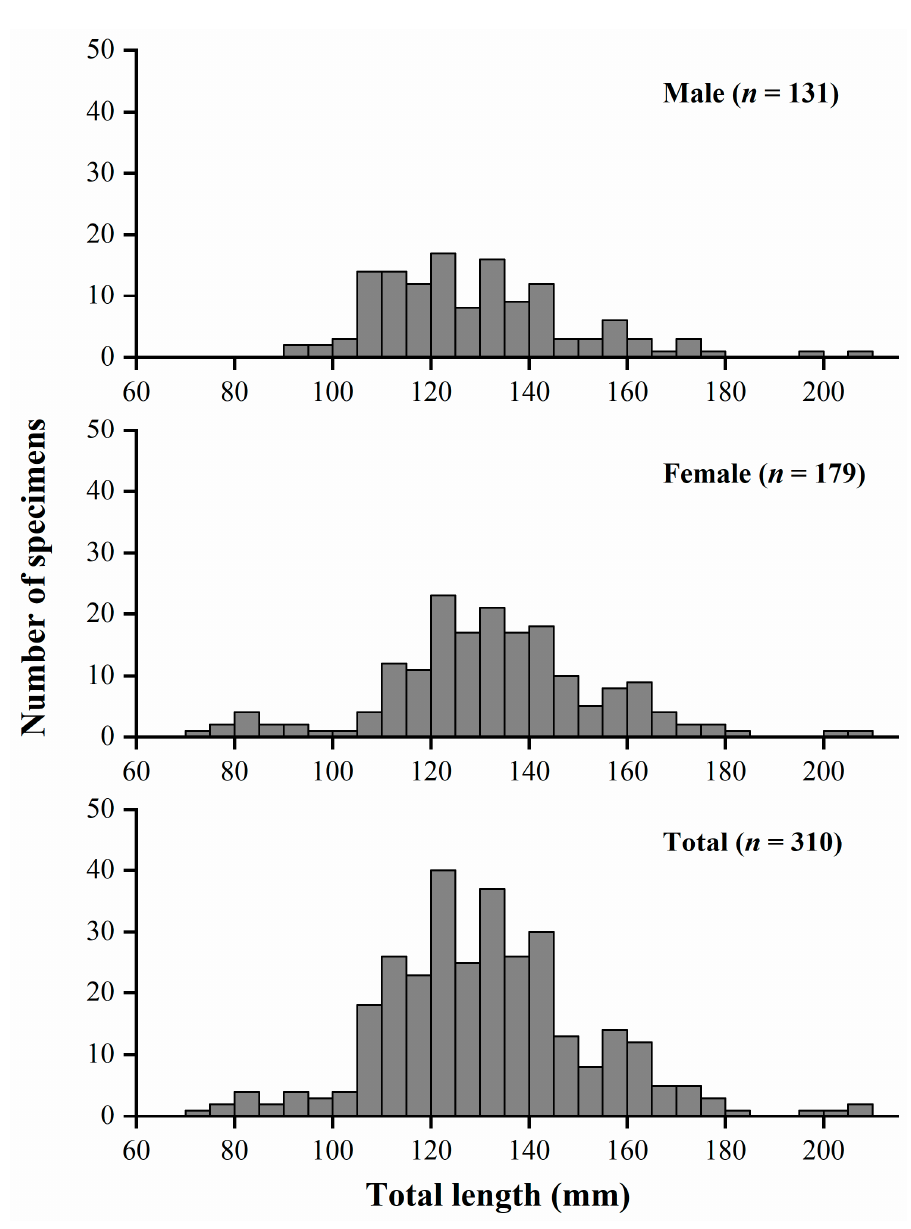
Figure 3. Size frequency distribution of males, females and all samples combined of Pseudecheneis sulcatus captured in the lower Yarlung Zangbo River.